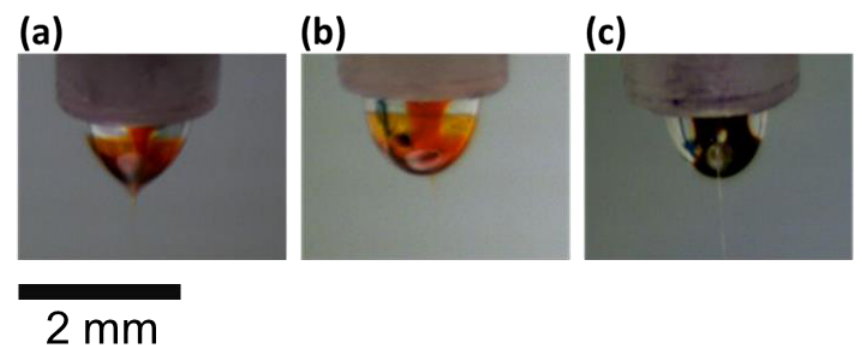
Figure 3. Charge-coupled Device ( CCD) images of Taylor cone in ( a ) CF, ( b ) CB and ( c ) TCB systems.